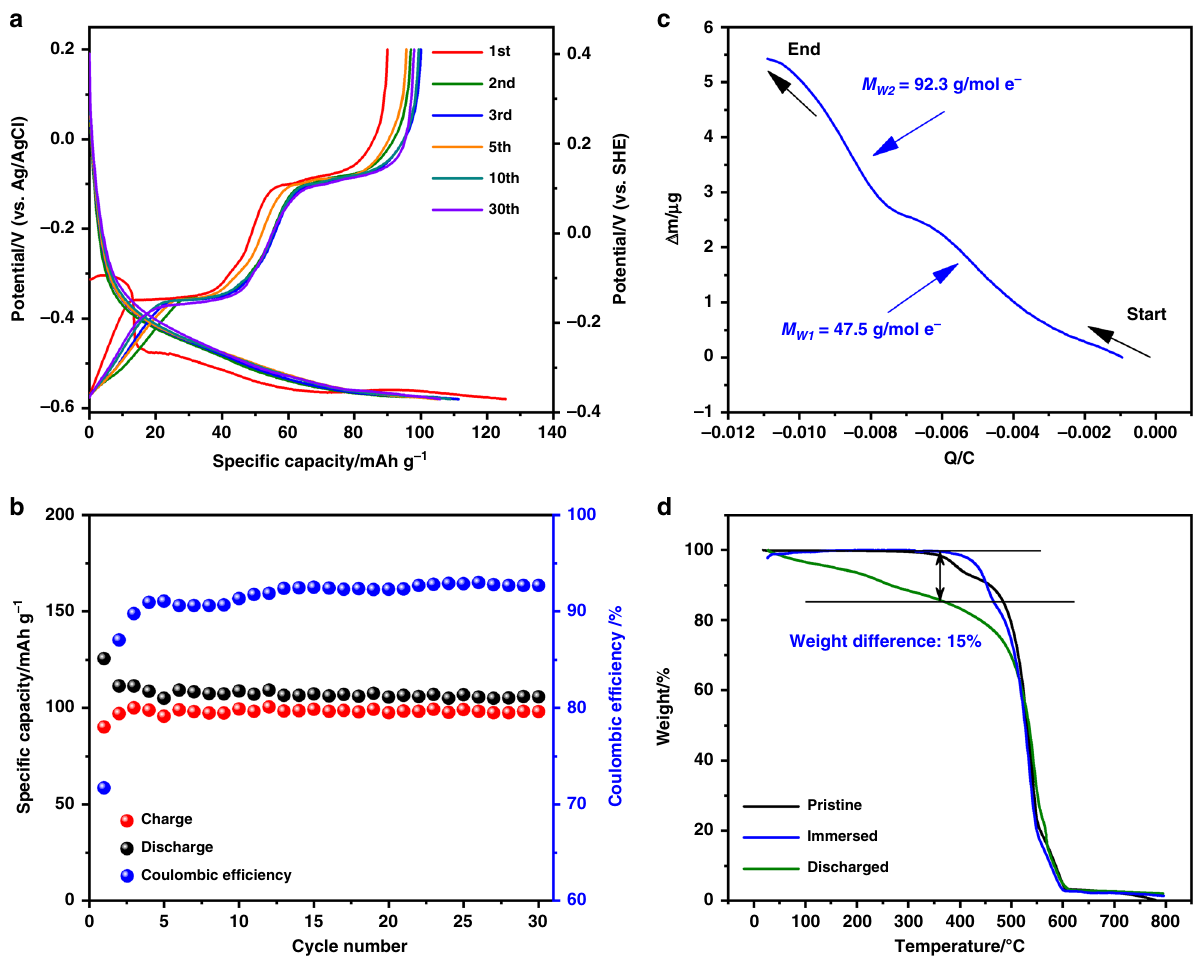
Fig. 2 Electrochemical performance of MV 2 + intercalation in PTCDA electrodes. a GCD potential pro fi les of PTCDA between − 0.58 and 0.2V (vs. Ag/AgCl) at a current rate of 100mAg − 1 ; b Galvanostatic cycling of the PTCDA electrode at 100mAg − 1 for 30 cycles; c EQCM curve recorded during a typical cathodic CV scan; d The TGA pro fi les of the pristine electrode, the electrolyte-immersed electrode, and the discharged electrode tested under air fl